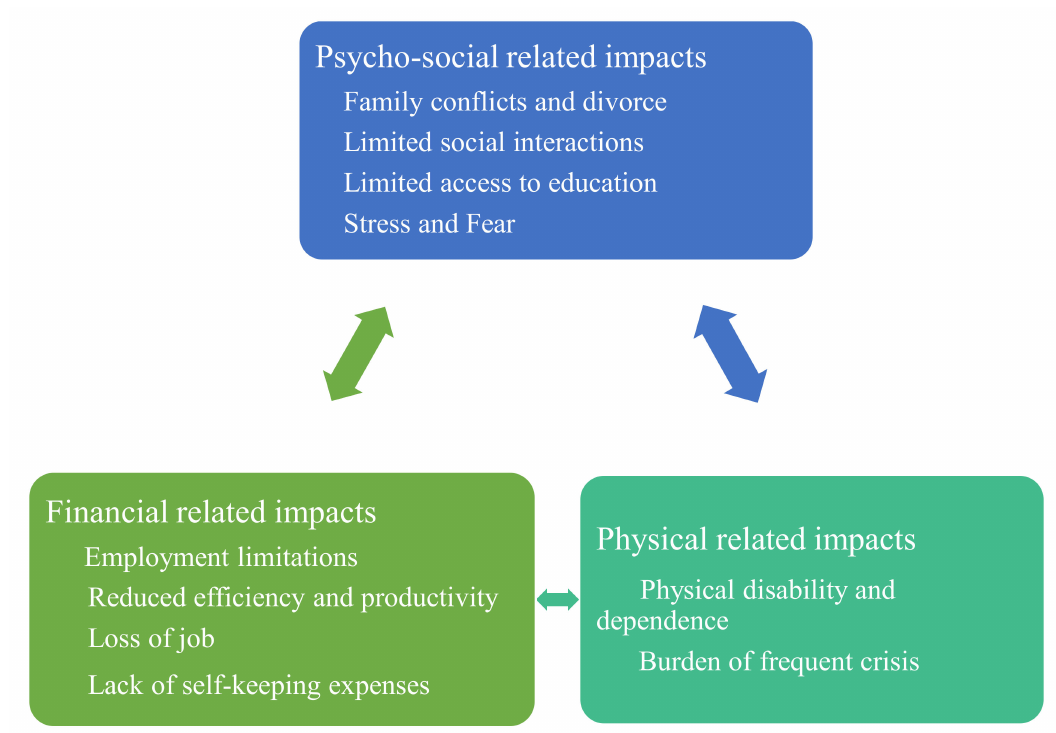
Figure 1. Summary of findings on the effect of SCD on the quality of life among children living with SCD and their